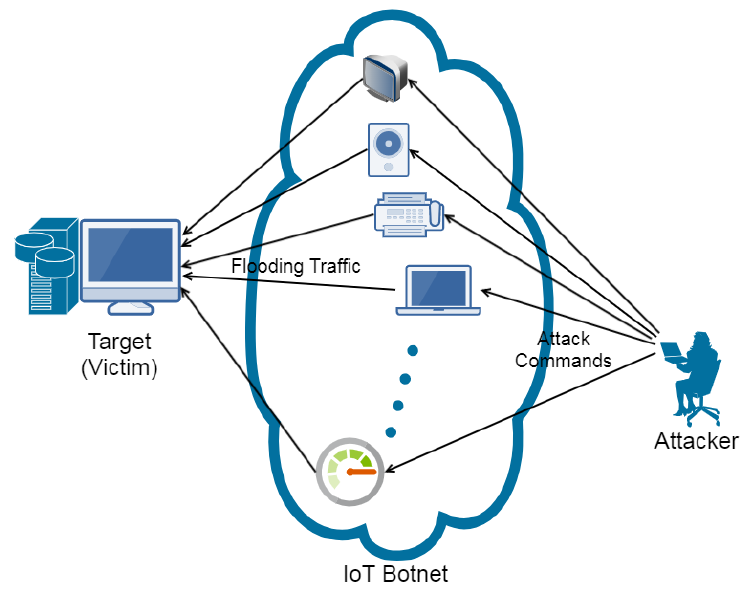
Figure 1. Schematic diagram of DDoS attack.